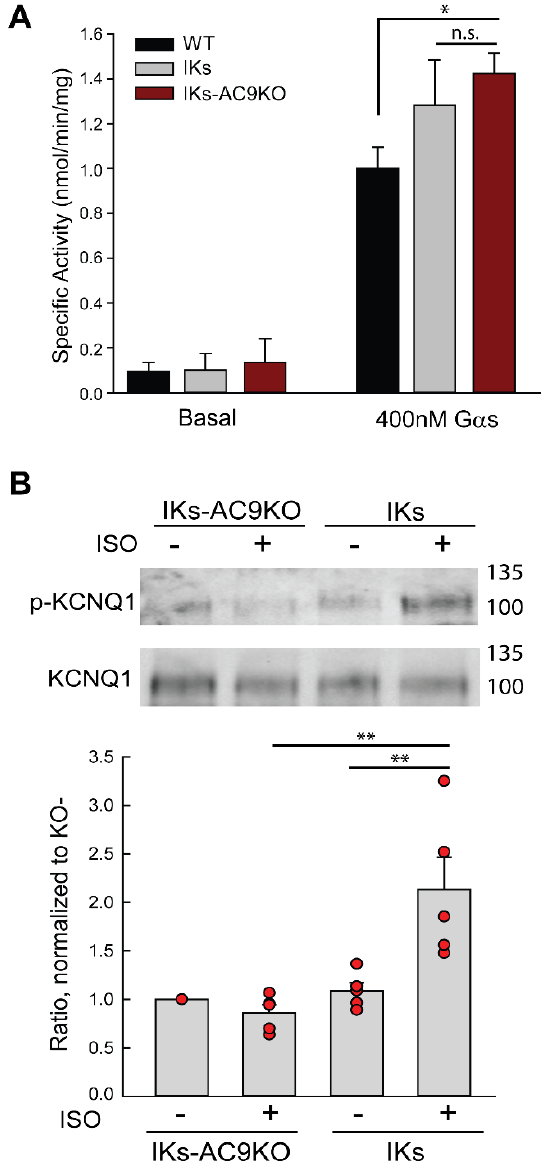
Figure 2. AC9 is required for sympathetic stimulation of KCNQ1 phosphorylation in vivo. Membranes were prepared from IKs-WT versus IKs-AC9KO heart. ( A ) AC activity was